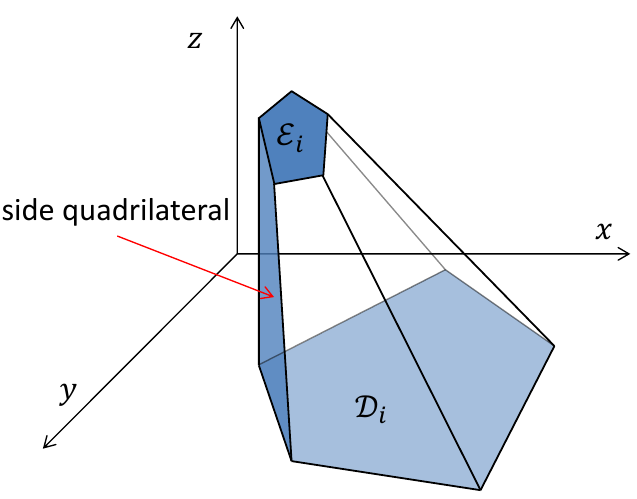
Figure 2. An illustration of a very uneven